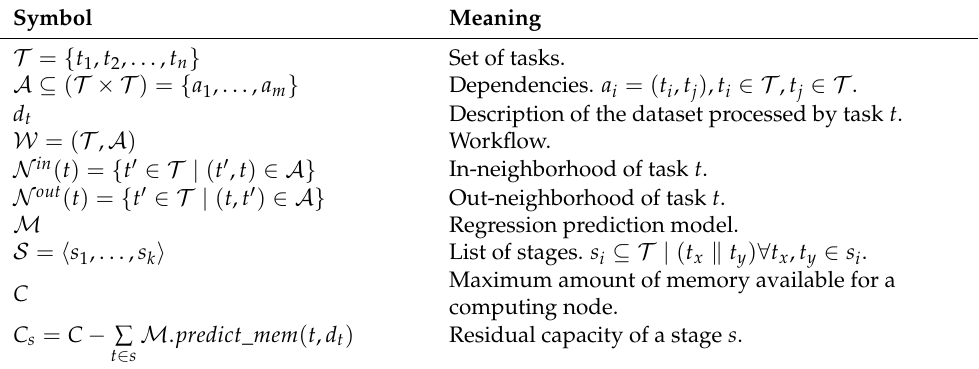
Table 1. Meaning of the main